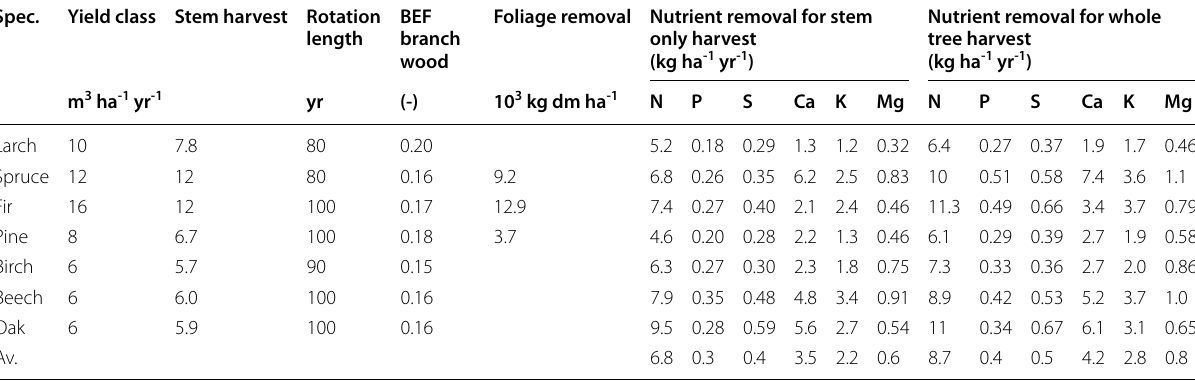
Table 4 Nutrient removal (kg ha -1 yr -1 ) for stem only harvest and whole tree harvest at final felling, for given yield classes (max. average increment, m 3 ha -1 yr -1 ), average stem harvest over the rotation (m 3 ha -1 yr -1 ), rotation length (yr) and biomass expansion factors at final felling (BEF) for branch wood (-). The table also gives foliage removal at final felling of Scots pine, Douglas fir and Norway spruce when applying whole tree harvest (10 3 kg dm ha -1 ) Spec.